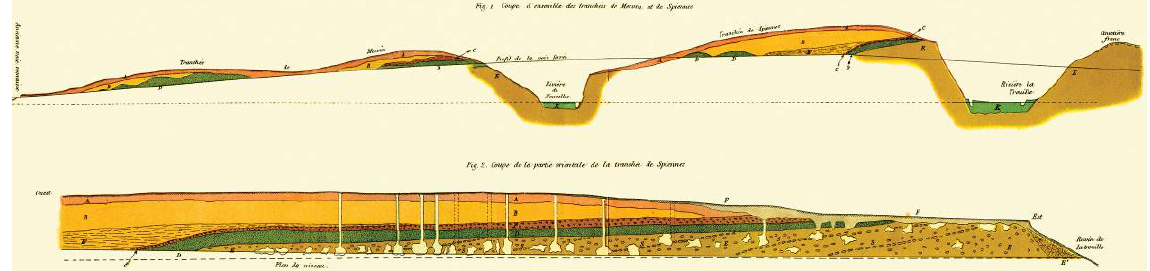
Figure 5. Petit-Spiennes. ‘Cornet’ cross section drawn during the trenching of the railway in 1867 (Briart et al.